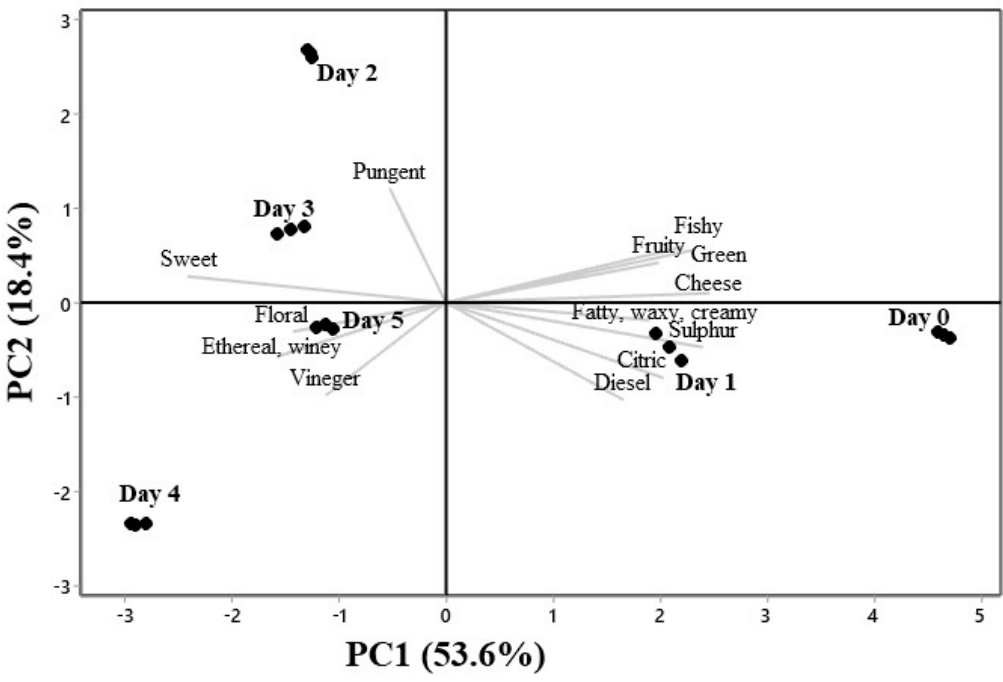
Figure 4. Principal component analysis bi-plot of the composition of flavor attributes of the volatile compounds detected, as correlation loadings in fermented sotol ( Dasylirion sp.) must at different days ( • ) of the process as scores.